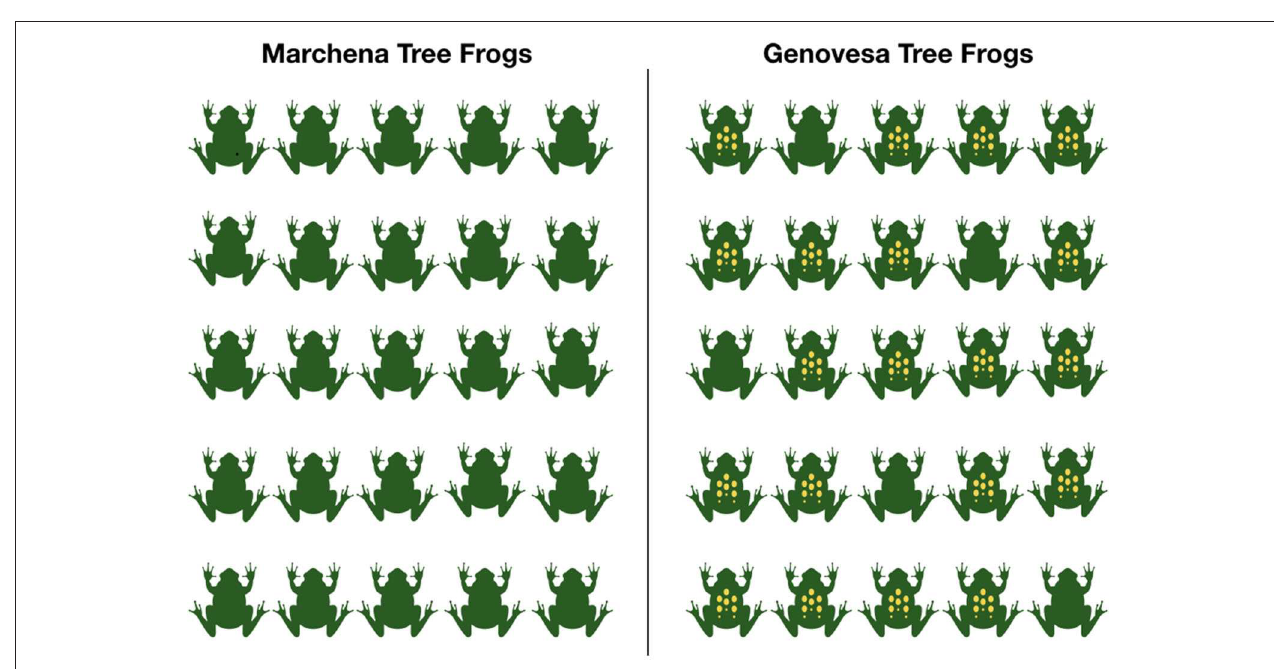
FIGURE 2 | Sample picture in the contrastive condition with